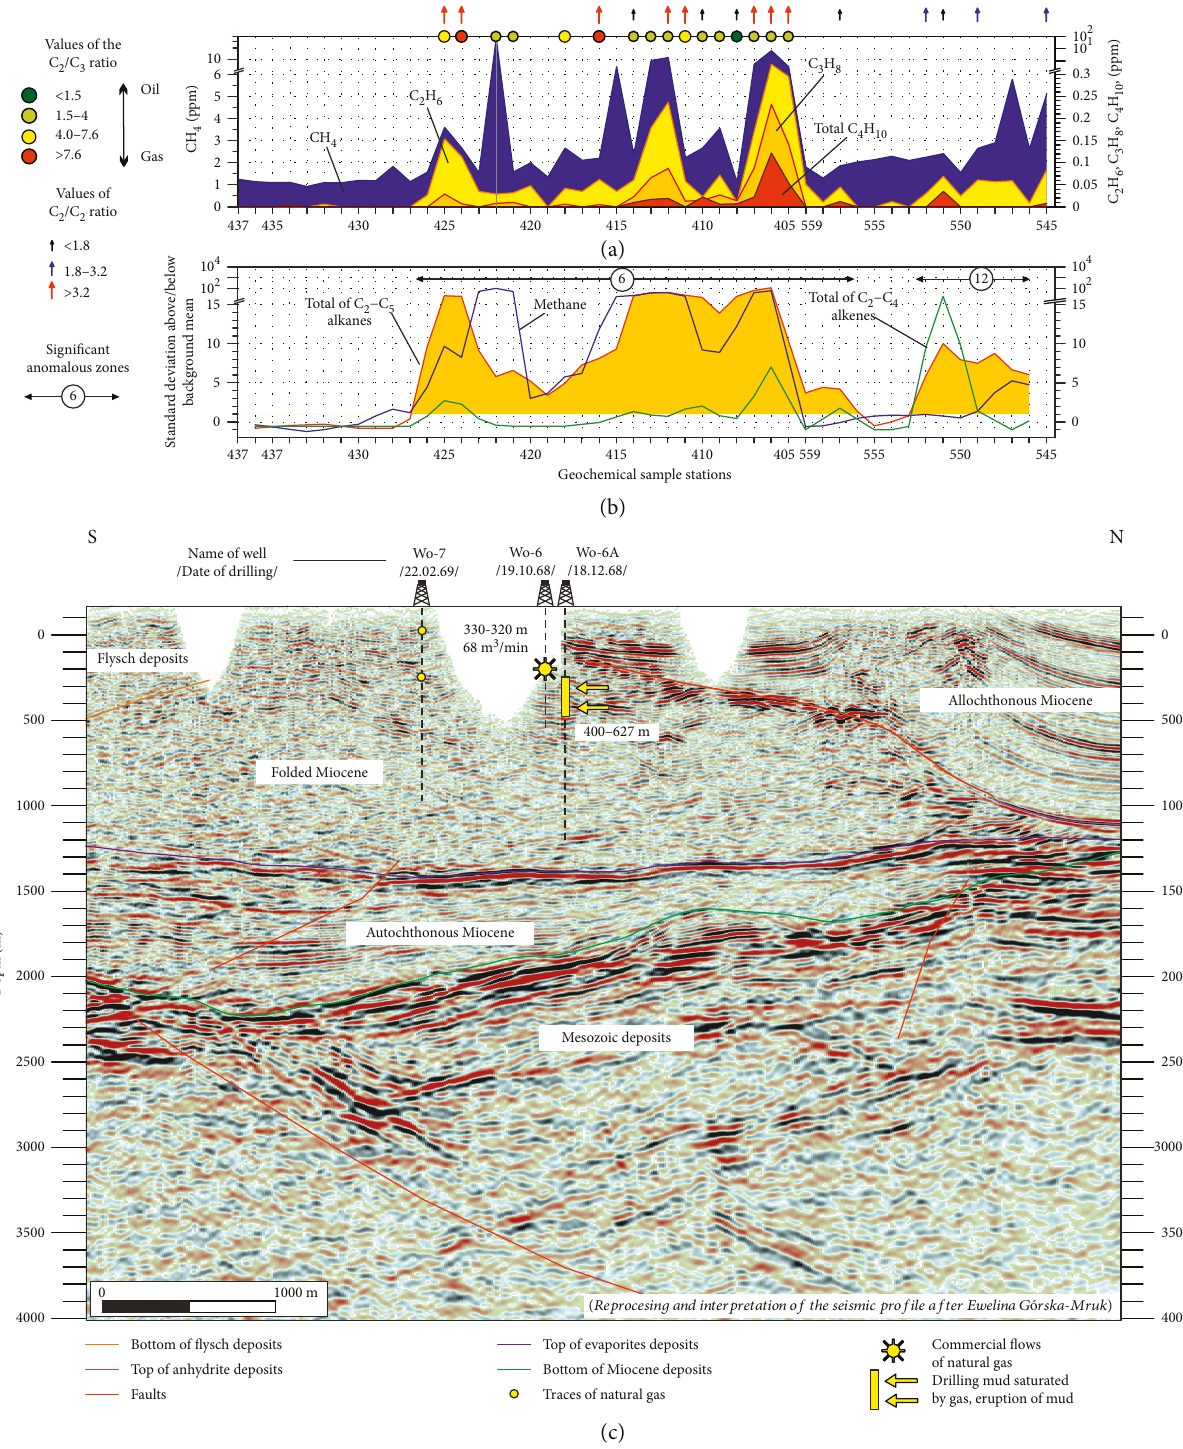
Figure 10: Variations in soil gas geochemistry along the E-E ′ seismic pro fi le (see the location in Figures 1(b) and 9). (a) Graphs show variations in measured concentrations of alkanes as well as in C graphs show variations in normalized concentrations of total alkanes C section along the E-E ′ seismic